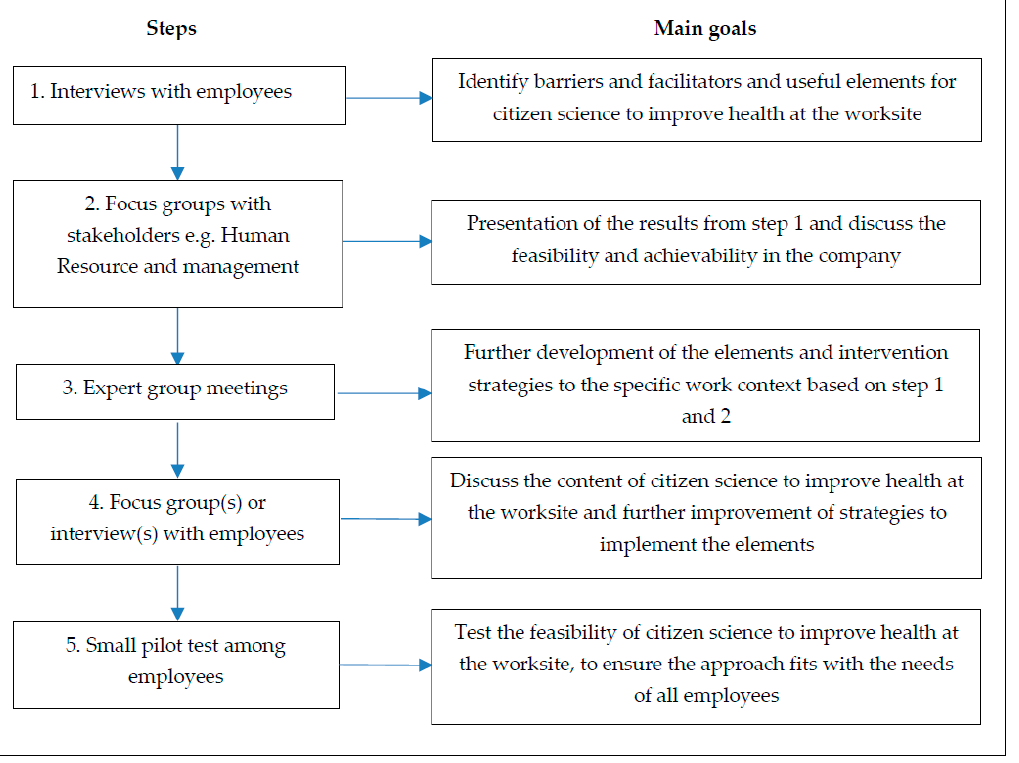
Figure 1. A flowchart of the different steps taken to adapt citizen science to improve health in an occupational setting.